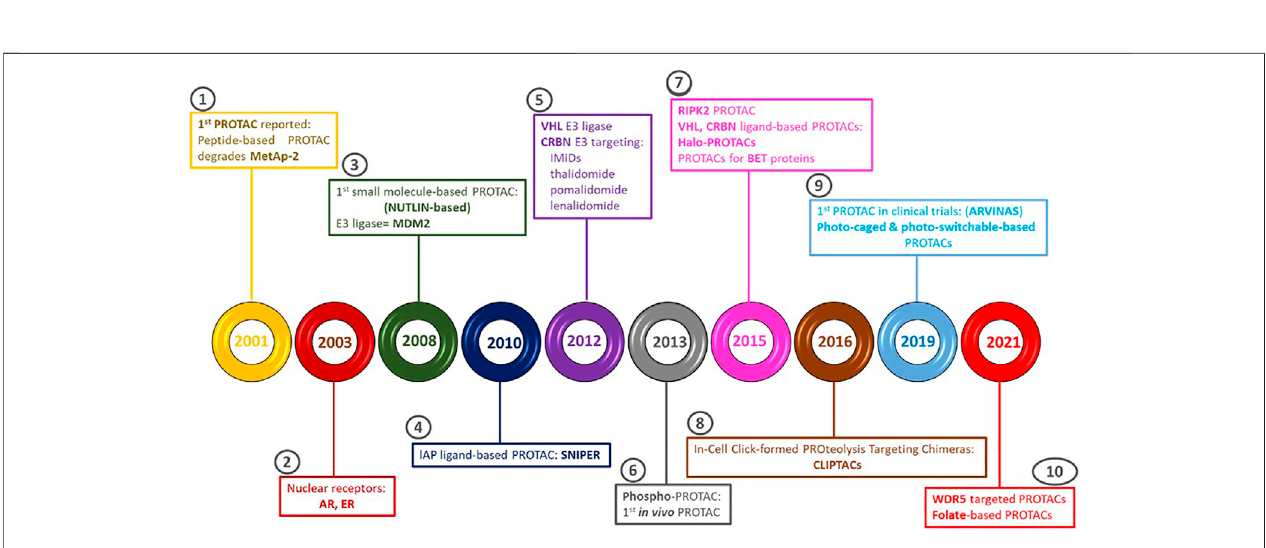
FIGURE 2 | The 10 main events related to PROTACs technology development for clinical translation. (1)The fi rst PROTACs technology based on a peptide was reported to degrade Methionine aminopeptidase 2 (MetaP2), an enzyme overexpressed in many forms of cancer (Sakamoto et al., 2001). (2) Novel PROTACs that induced degradation on androgen (AR) and estrogen (ER) receptors con fi rmed the proof of preclinical ef fi cacy. (3) The fi rst small-molecule PROTACs was reported in 2008,con fi guredbymurinedoubleminute2(MDM2)asE3-ligase(Schneeklothetal.,2008).(4)Inhibitorsofapoptosisproteins(IAP)wereattainedinthePROTACs structure as E3-ligase (Itoh et al., 2010). (5) Not only peptidomimetic ligands for VHL E3 were developed but CRBN E3 was identi fi ed as molecular targeting for immunomodulators, thalidomide, pomalidomide and lenalidomide (Ito et al., 2010; Itoh et al., 2010; Buckley et al., 2012). (6) The fi rst PROTACs working in vivo , phosphor-PROTACs, were capable of inhibiting the tumoural growth in murine models, differentiating between various receptor tyrosine kinases (RKT) signalling routes (Hines et al., 2013). (7) The serine-threonine-protein kinase (RIPK2) receptor-interactor PROTACs that selectively induced degradation of RIPK2 at low doses were developed.Simultaneously,theusefulnessofVHLE3tofacilitateguided degradationwasdemonstrated byitsinclusioninHaloPROTACs.Additionally,PROTACsusing BromoandExtraterminaldomains(BET)inhibitorstargetingBETproteins,usingbothCRBNandVHL,weredeveloped(Bondesonetal.,2015;Winteretal.,2015).(8)In- cellCLIck-formedProteolysisTargetingChimeras(CLIPTACs) weredeveloped byAstexPharmaceuticals(Lebraud etal.,2016).(9)Arvinas developed the fi rstPROTAC tested in clinical trials. Photocontrol groups were incorporated into PROTACs (Xue et al., 2019) (10) New WDR5 targeting PROTACS were designed based on existing WDR5 ligands (Poso 2021), and folate based PROTACs were released to speci fi cally deliver PROTACs in a controllable manner to degrade the POI, thus eliminating potential unwanted toxicity to normal tissues (Liu et al., 2021c).